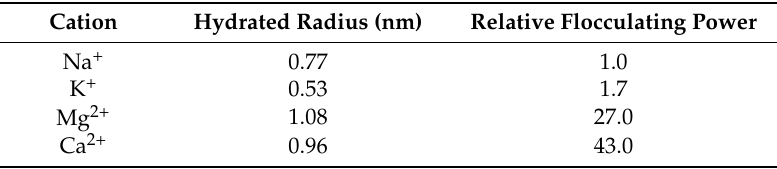
Table 1. Influence of the cations on relative flocculating